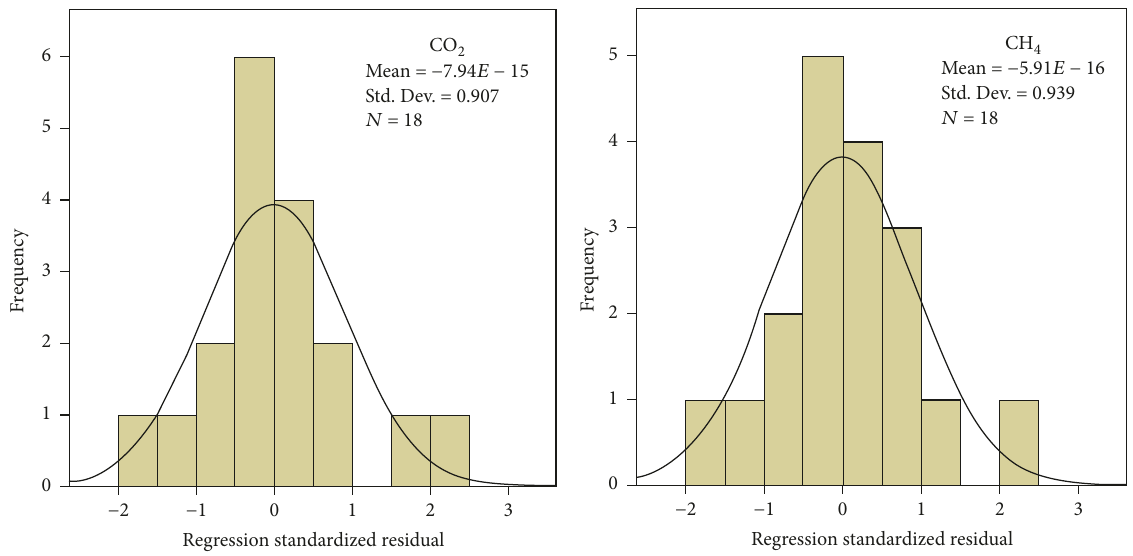
Figure 6: The normal distribution histogram of regression standardized residual of lgCO 2 and lg CH 4 .